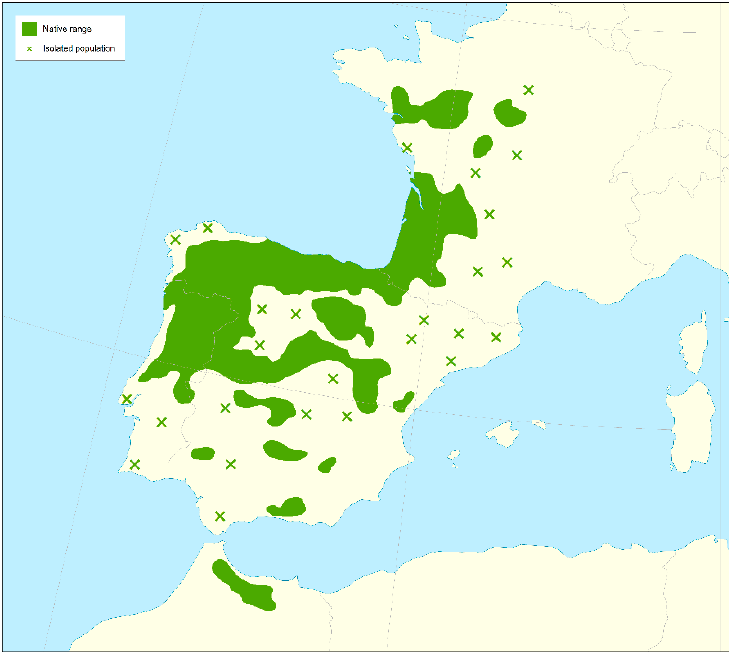
Figure 2. Quercus pyrenaica Willd distribution map [62]. https://commons.wikimedia.org/wiki/File:Quercus_pyrenaica_range.svg.